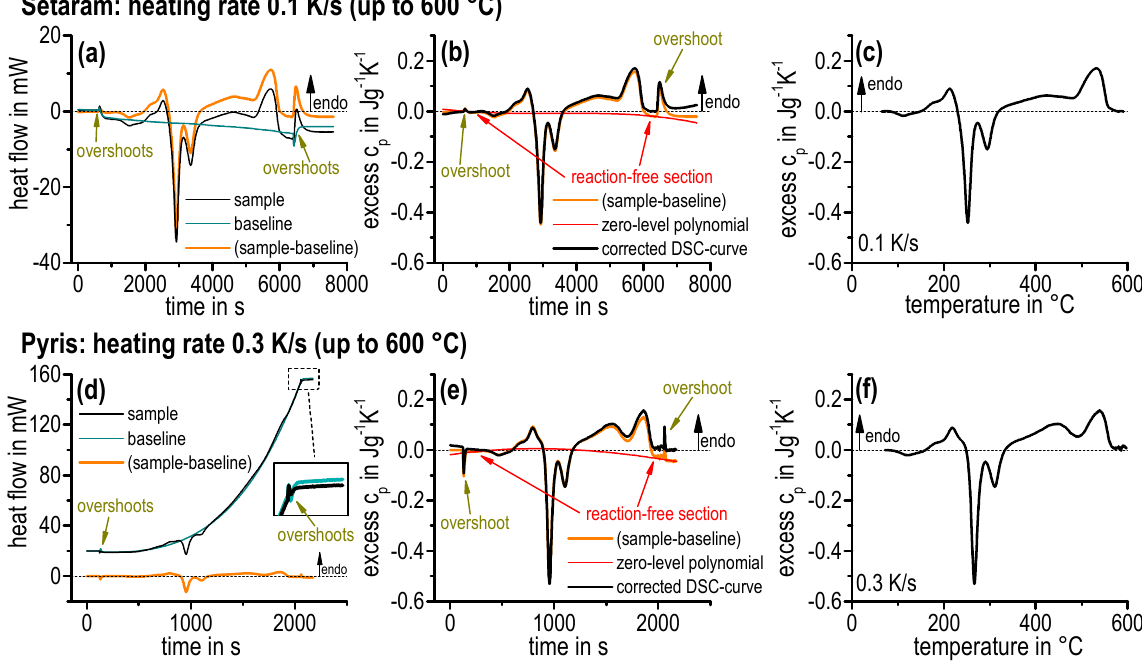
Figure 3. Data handling to obtain an undistorted normalised DSC heating curve by means of data from several devices using the example of EN AW-6181